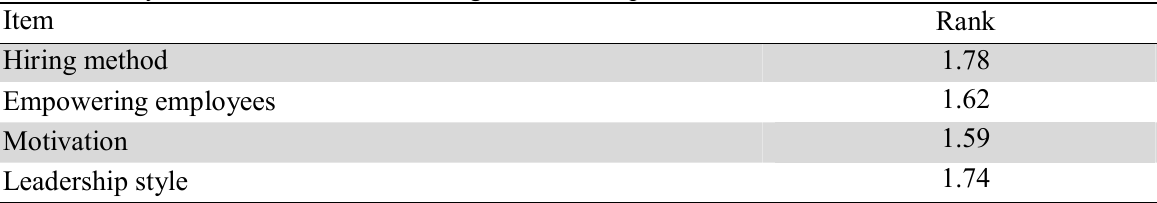
The summary of Freedman test on ranking various